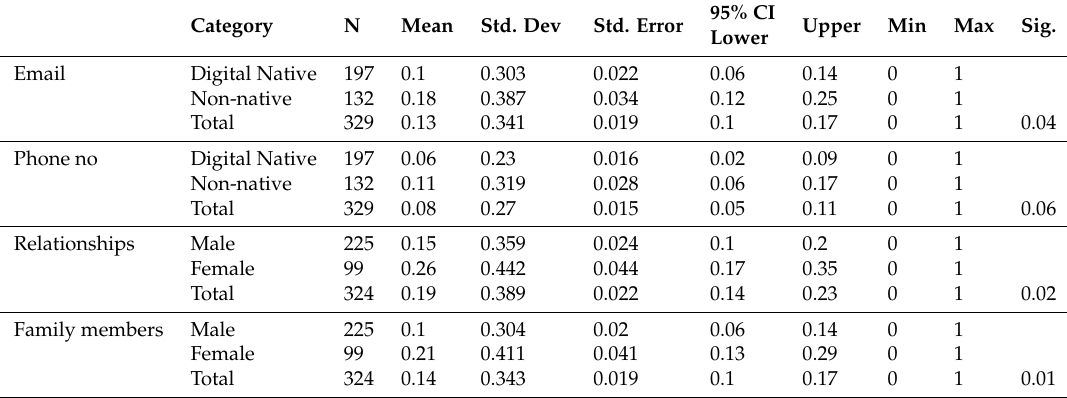
Table 13. What information do you have visible to the public on your